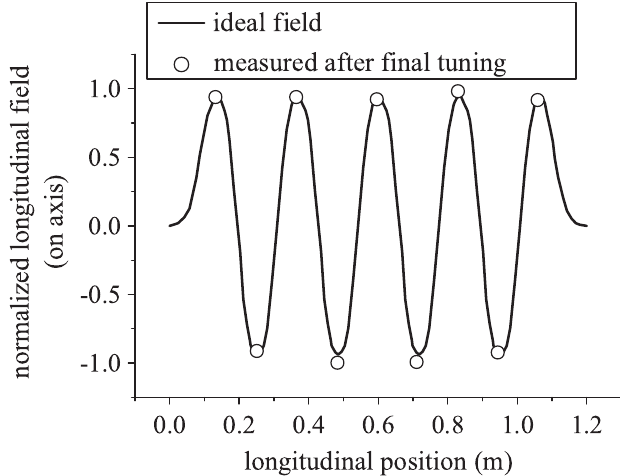
FIG. 3. Field distribution on the axis of the booster cavity. Field amplitudes in cells measured after the final tuning shown with